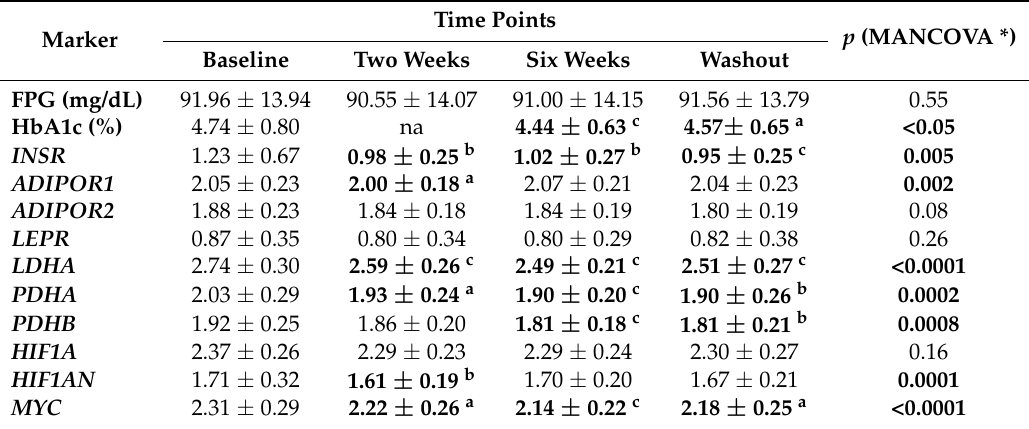
Table 3. The effect of Se supplementation on fasting plasma glucose concentration, HbA1c levels and gene expression. Data for all study subjects ( n =